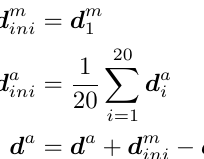
Table 3: Parameters obtained using parameter identi- fication. All units are